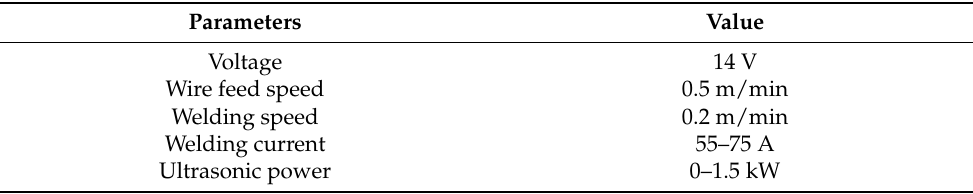
Table 2. The welding parameters used during the UVAW process.